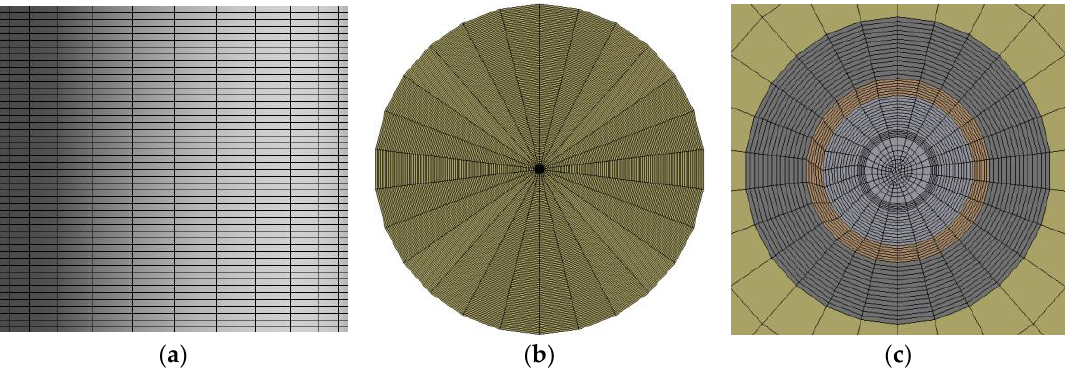
Figure 8. Mesh discretization. ( a ) Radial to borehole axis view. ( b ) Vertical to borehole axis view. ( c ) Local borehole view.